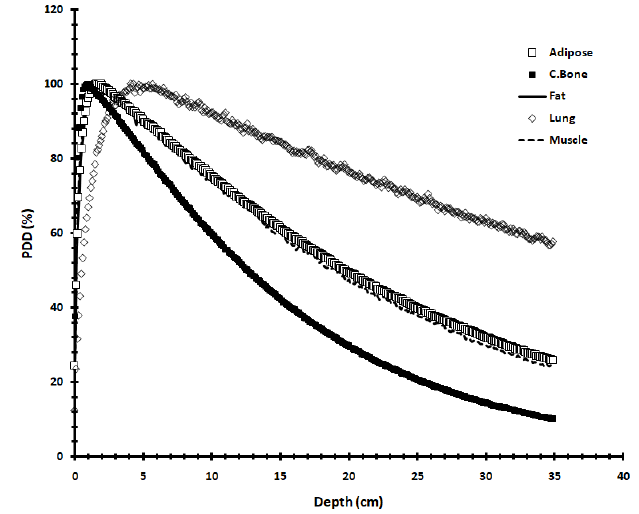
Figure 3. Geant4-simulated PDD of adipose, cortical bone, fat, lung and muscle tissues for a 10 × 10 cm 2 field size of a 6 MV photon beam.